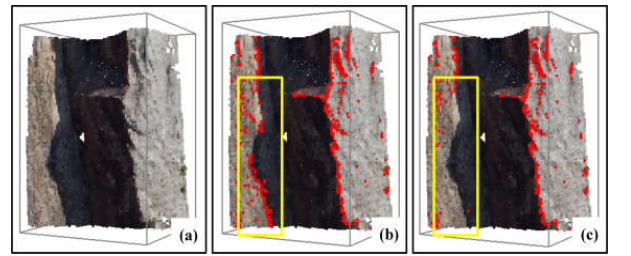
Figure 8. The results of the actual test case. ( a ) Shadows from light; ( b ) potential discontinuity trace points extracted from the color attributes; ( c ) the result of introducing the light and shadow